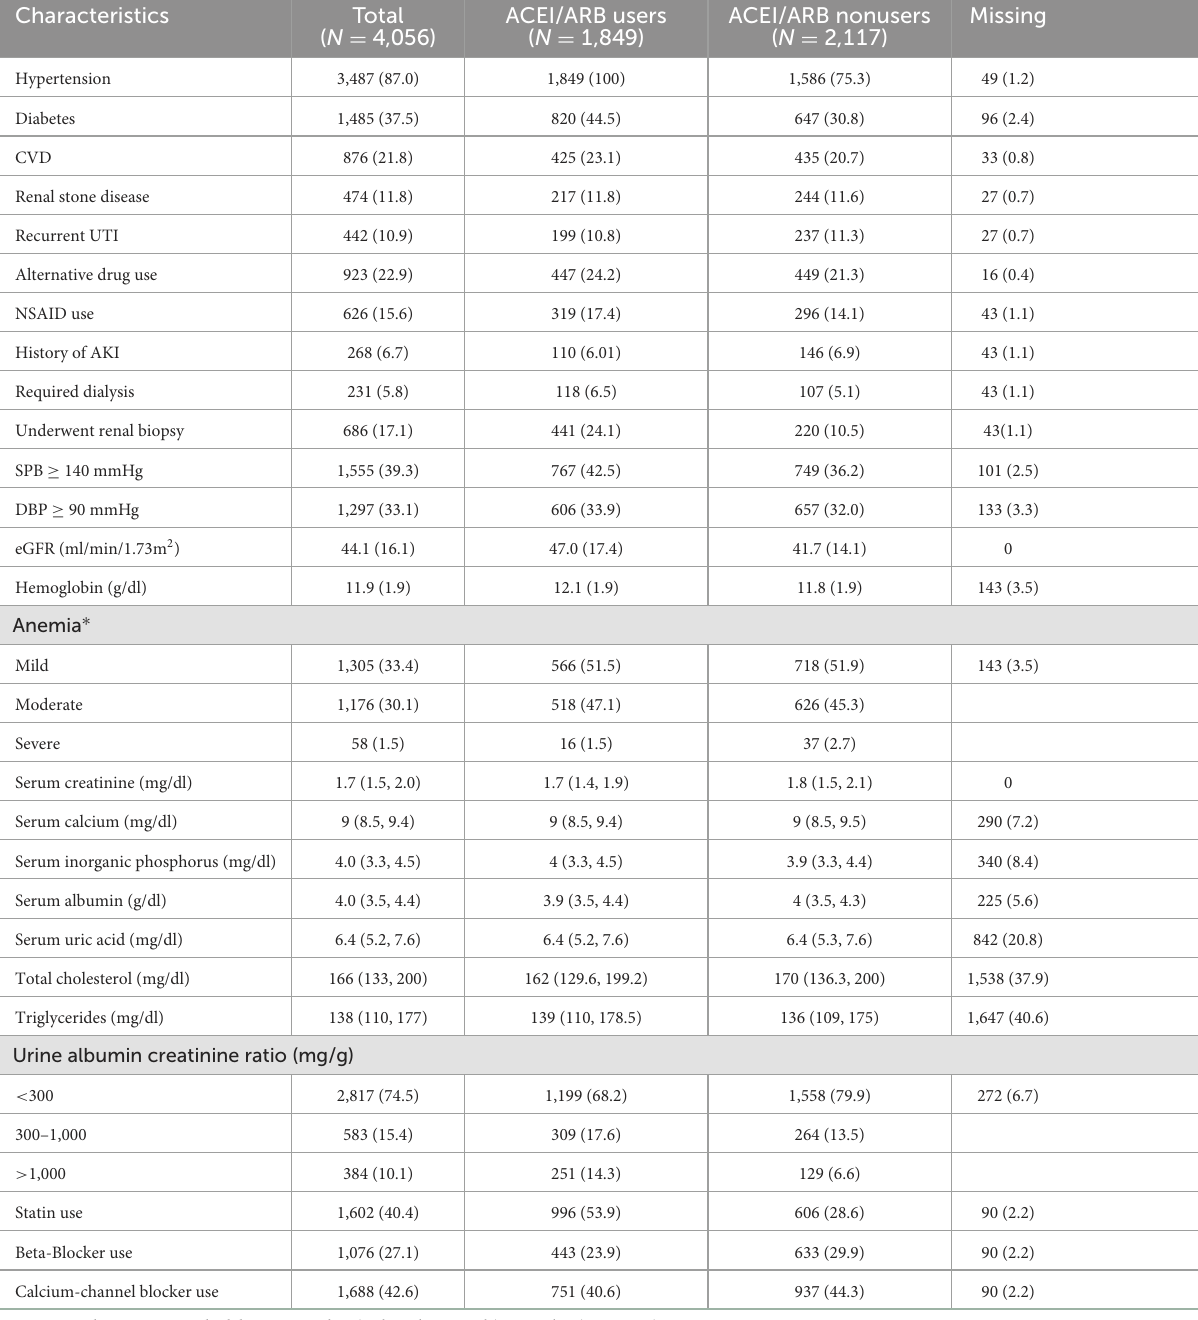
TABLE 2 Baseline clinical characteristics of participants in the study.